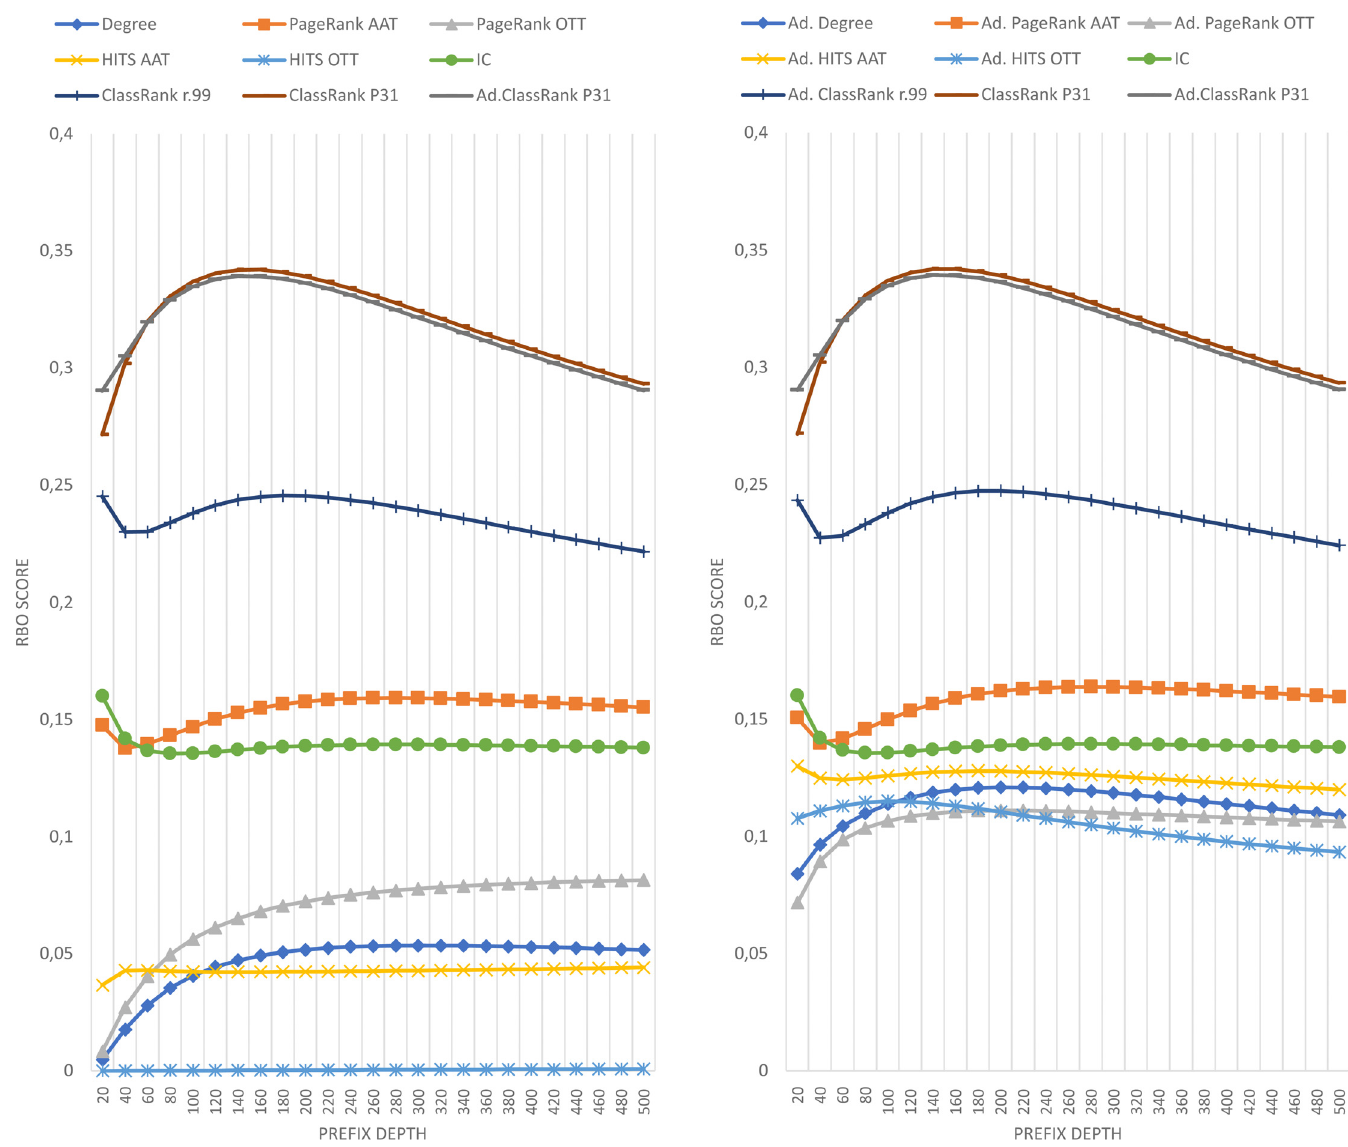
Fig 4. Comparison of techniques against HH log in